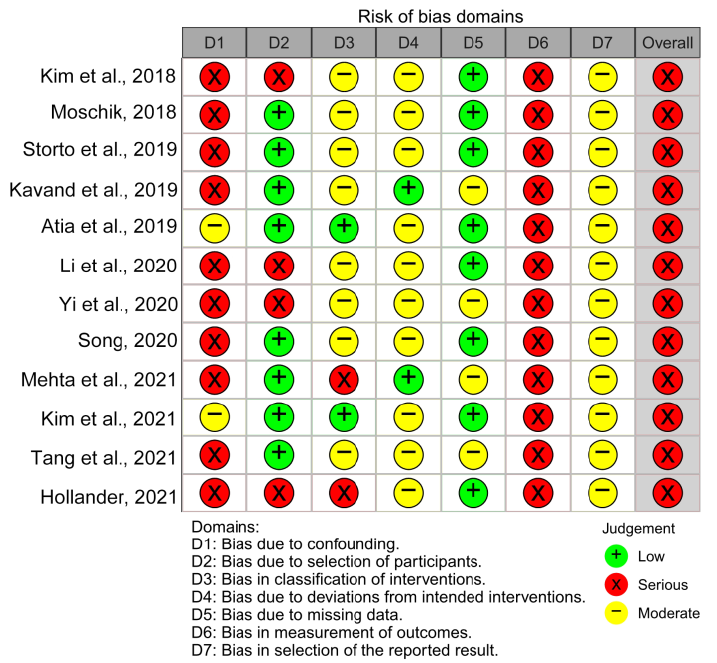
Figure 2. Results of the risk of bias assessment in the individual studies with the Risk Of Bias In Non-randomized Studies—of Interventions (ROBINS)-I tool [26,30–41].